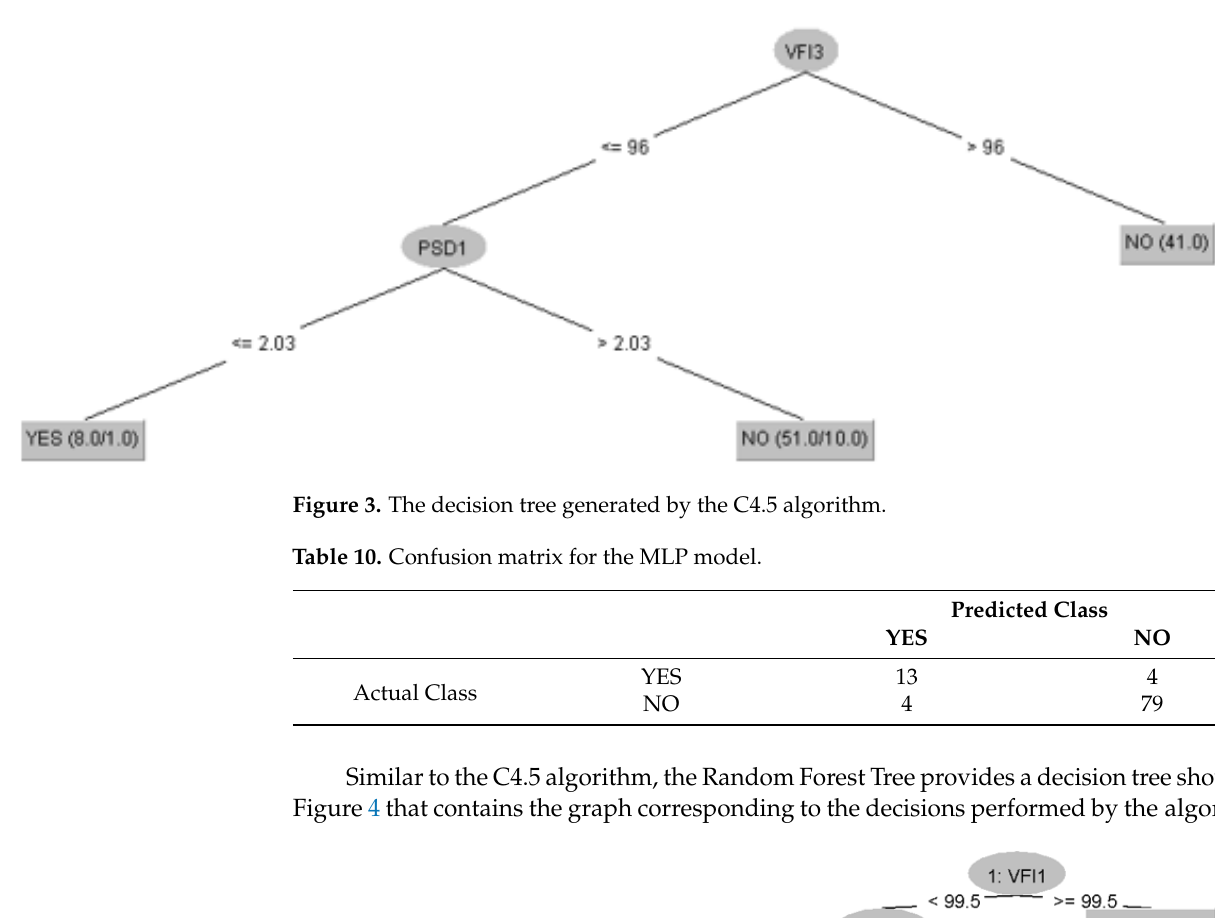
Table 10. Confusion matrix for the MLP model.